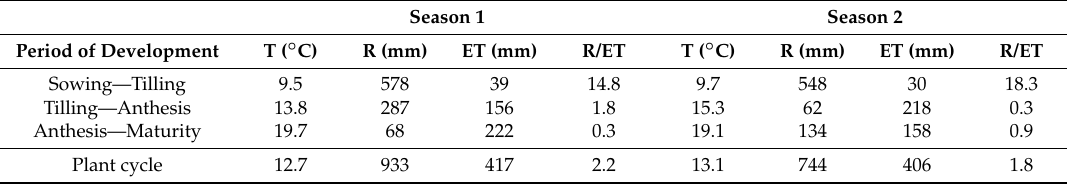
Figure 4. The different treatments based on excision and/or shading used to study sink-source relations on six durum wheat genotypes grown under field Mediterranean conditions. Table 5. Mean values of temperature (T), cumulative values of rainfall (R) and of evapotranspiration (ET) as well as their ratio (R/ET) at different growth stages of the six wheat genotypes during the two growth